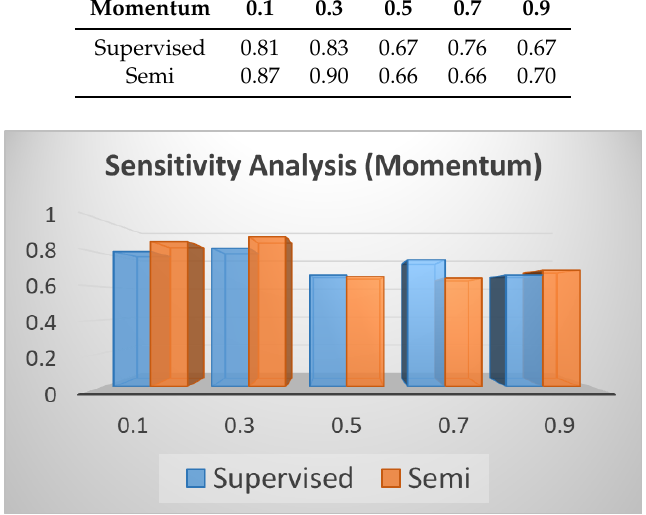
Figure 12. Sensitivity Analysis (Momentum).